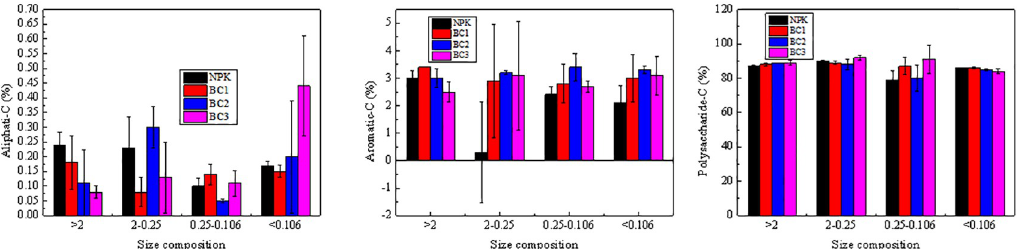
Fig 4. Composition of organic carbon functional groups present in soil